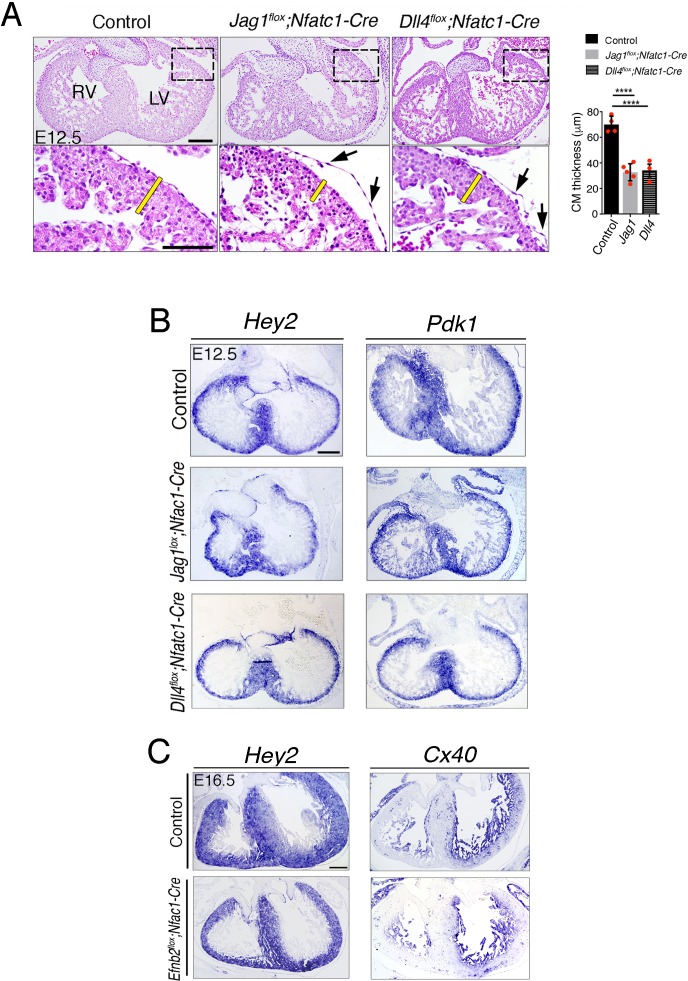
Histological and molecular marker analysis of E12.5 Jag1flox;Nfatc1-Cre, and Dll4flox;Nfatc1-Cre and E16.5 Efnb2flox;Nfatc1-Cre hearts.(A) H and E staining on control, Jag1flox;Nfatc1-Cre, and Dll4flox;Nfatc1-Cre heart sections. Arrows point to detached epicardium. Yellow bars indicate compact myocardium (CM) thickness. Quantified data of CM thickness in control, Jag1flox;Nfatc1-Cre and Dll4flox;Nfatc1-Cre hearts. Data are mean ± s.d. (n = 4 control hearts and n = 5 for Jag1flox;Nfatc1-Cre and n = 3 for Dll4flox;Nfatc1-Cre mutant hearts). ****p<0.0001 by one-way ANOVA with Tukey’s multiple comparison tests. (B) Endocardial Jag1 or Dll4 deletion does not affect myocardial patterning. ISH of the compact myocardium markers Hey2 and Pdk1 on control, Jag1flox;Nfat-Cre, and Dll4flox;Nfatc1-Cre heart sections (C) ISH of the compact myocardium marker Hey2, and trabecular myocardium marker Cx40 on control and Efnb2flox;Nfatc1-Cre heart sections. Scale bars, 100 μm.